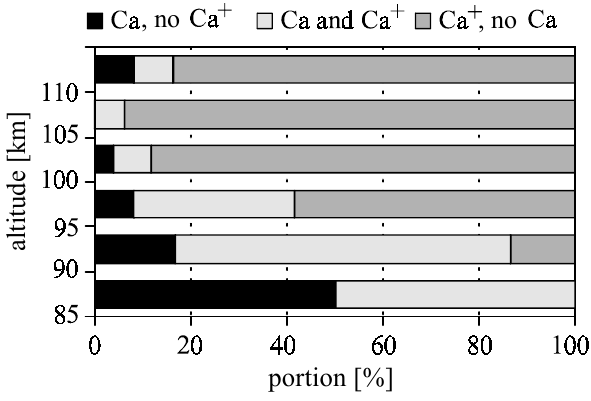
Fig. 8. Altitude distribution of joint and single-species sporadic Ca and Ca + layers as listed in Table 1 (columns 4 to 6).